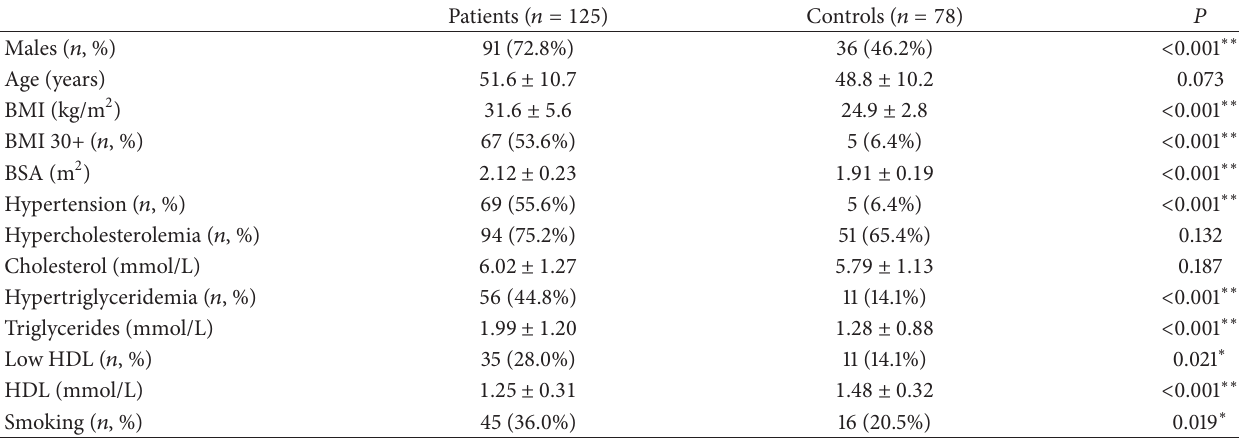
Table 1: Clinical characteristics of OSA patients and control subjects.